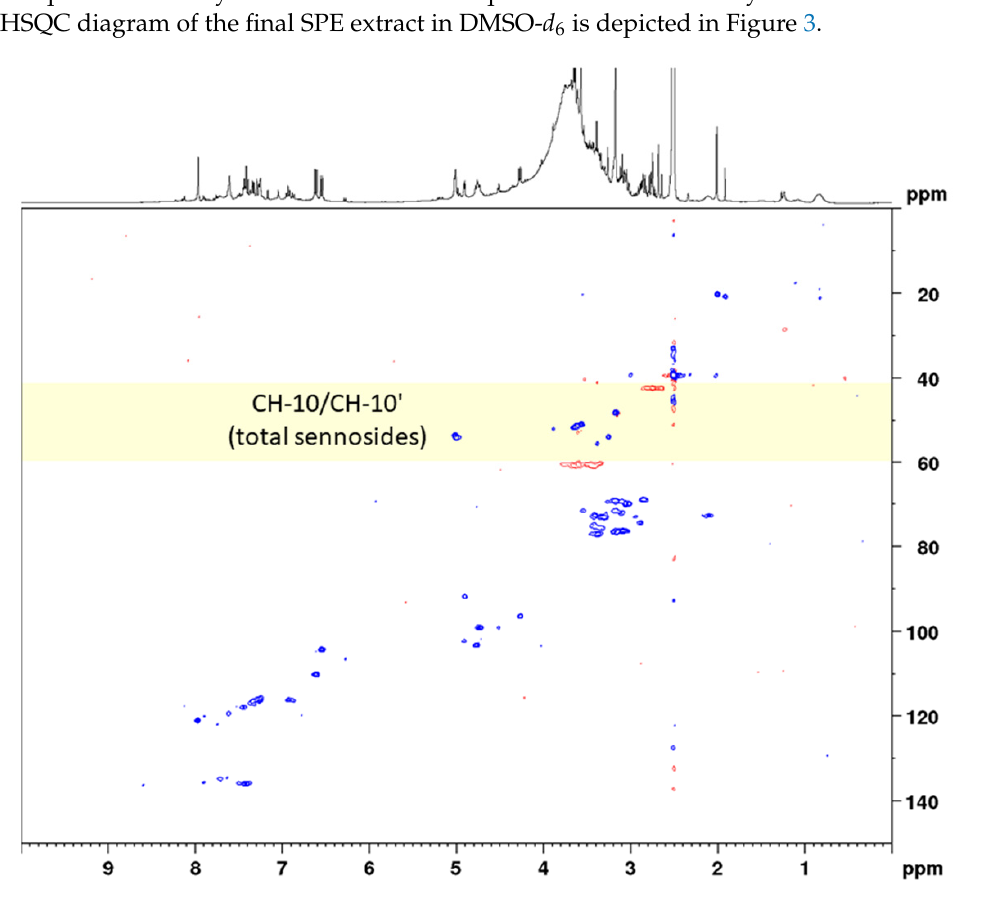
Figure 3. Complete spectral range HSQC diagram of senna solid-phase extract (1 g pods) in DMSO- d 6 with delays optimized for 138 Hz. The 13 C spectral range used for band-selective measurements is marked in yellow.